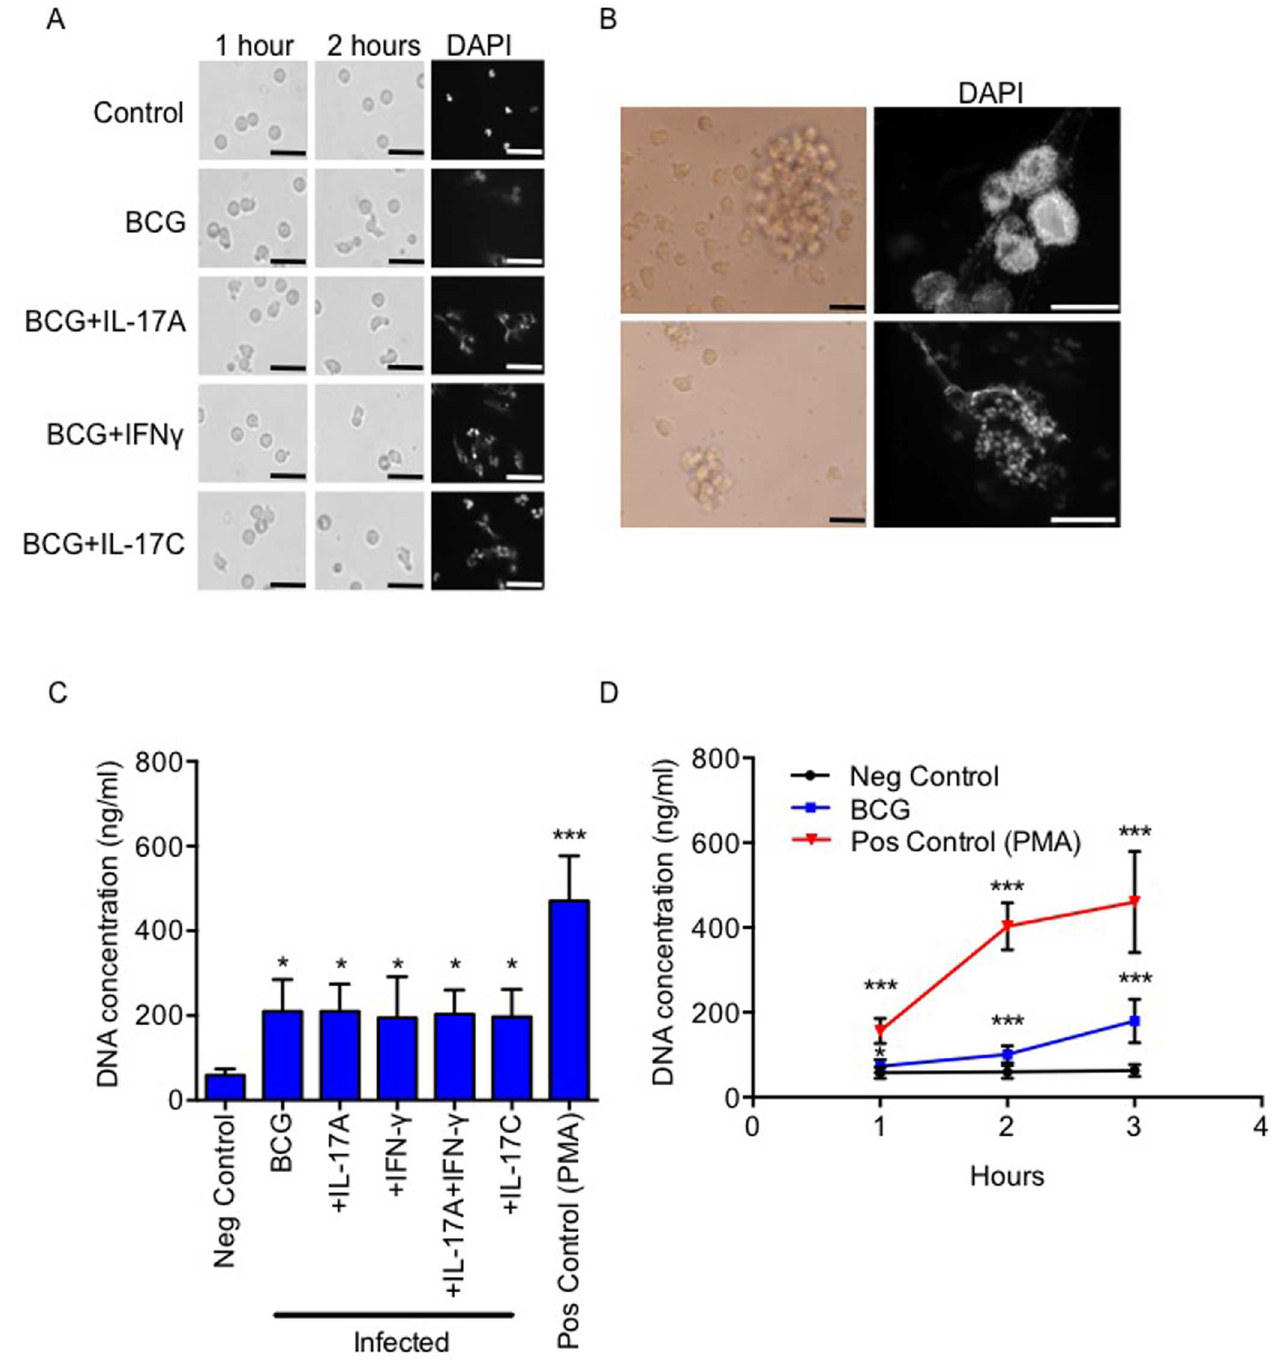
Fig 4. Production of Neutrophil extracellular traps (NETs) during BCG infection. Primary neutrophils were stimulated with BCG for one, two and three hours in the presence of IL-17A and/or IFN- γ . (A) NETs were studied in a light microscope after 2 hours and stained with DAPI and (B) large NET structures were observed in addition to single NETs. (C) Quantification of NETs was performed with Picogreen assay on cell supernatants after 3 hours and (D) over time at 1, 2 and 3 hours. Results are depicted as mean ± SD from a total of 4 donors. Means of samples were were comparedwith negative control using ANOVA followedby Dunnet’s multiple comparisons test and significance was accepted at * p < 0.05, ** p < 0.01, or *** p < 0.001. Bars represent 25 μ m (A, B left panel) or 100 μ m (B, right panel)